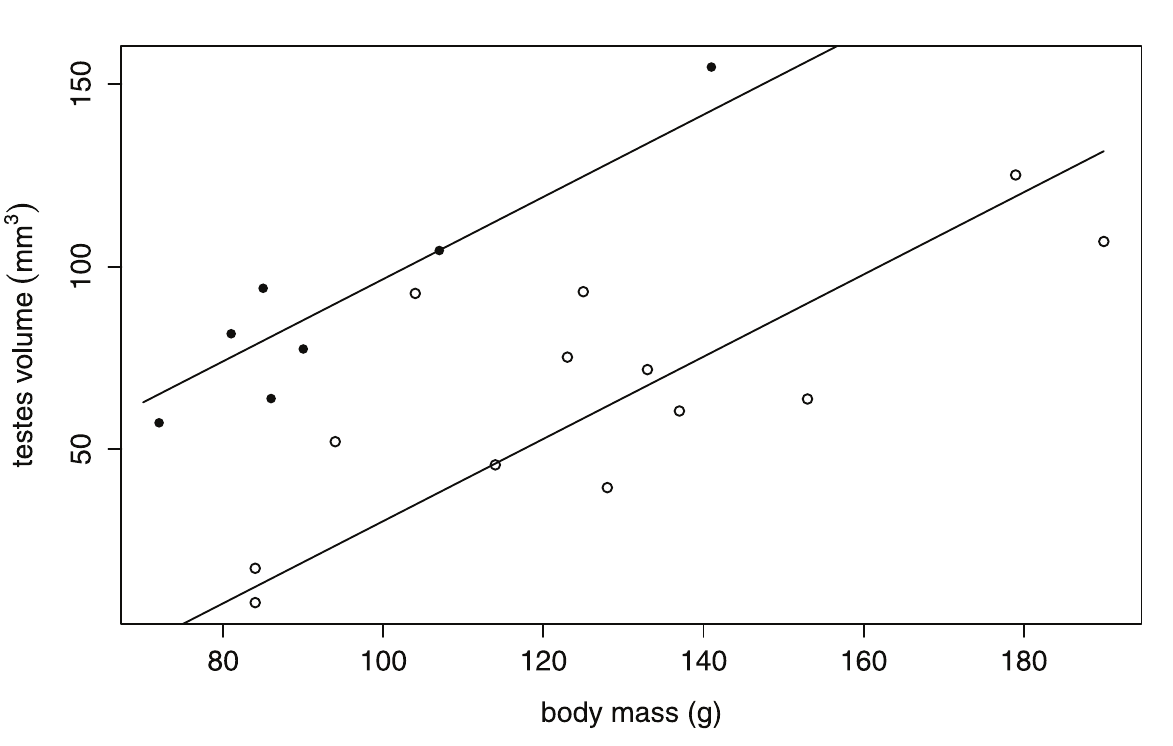
Fig 1. Reproductive males have larger testes compared to non-reproductive males. Absolute testes volume (mm 3 ) relative to body mass (g) for breeders (filled circles) compared to non-breeders (open circles) of Ansell ’ s mole-rats ( Fukomys anselli